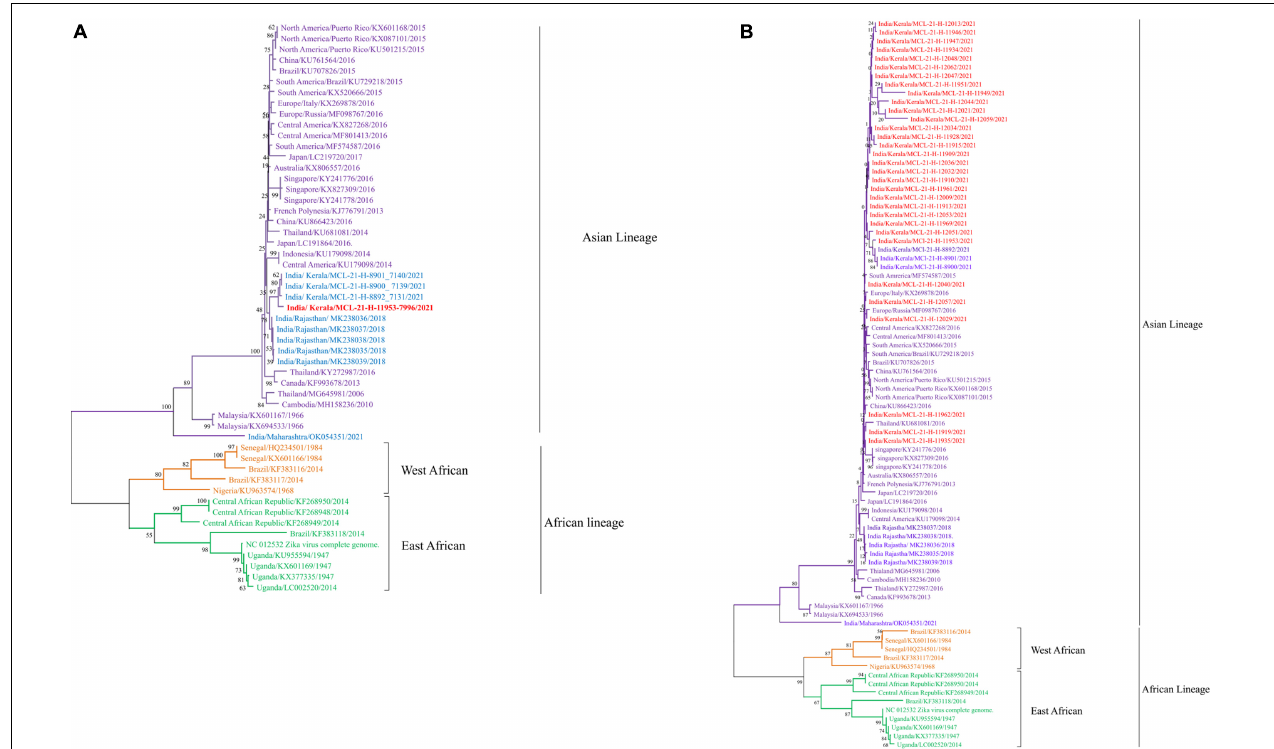
FIGURE 3 | (A,B) The Phylogenetic tree constructed with Neighbor Joining (NJ) method for ZIKV genome sequence using the Tamura 3 as substitution model and a bootstrap replication of 1000 cycles. (A) ZIKV complete genome sequence; (B) ZIKV partial envelope gene